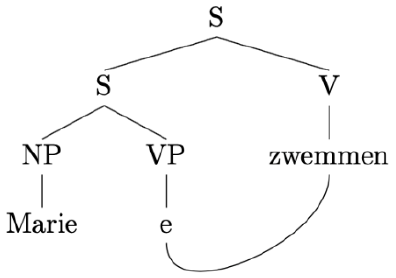
Figure 12. Elementary tree with VR